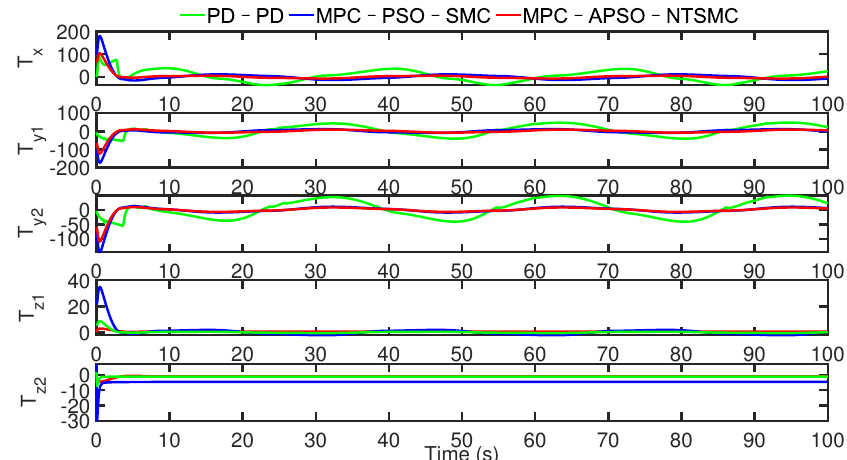
Figure 11. The thrust of thrusters for the tracking task without disturbance for Case 1.